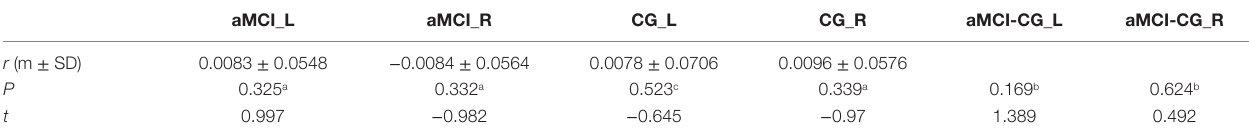
TaBle 2 | The correlation between frame-wise displacement (FD) and time series of the left/right fusiform gyrus in the two groups.